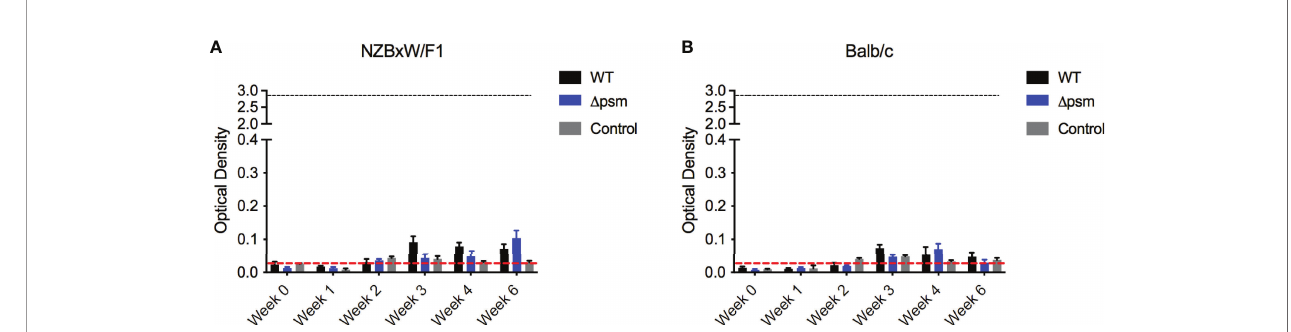
FIGURE 6 | Intraperitoneal infection with S. aureus wildtype SH1000 or D psm mutant does not induce autoantibody production. (A) NZBxW/F1 or (B) Balb/c mice were injected intraperitoneally with 10 7 S. aureus WT (black bars) or psm mutant ( D psm ) (blue bars) or PBS-injected control mice (gray bars). Serum was collected weekly to measure the levels of anti-dsDNA autoantibody production (optical density 650-405nm). Black dotted line represents the maximum autoantibody production of positive control sera and the red dotted line represent autoantibody detection in naïve serum. Mean and SEM graphed; signi fi cance was calculated using a 2-way ANOVA and Tukey ’ s multiple comparisons tests. No statistical signi fi cance